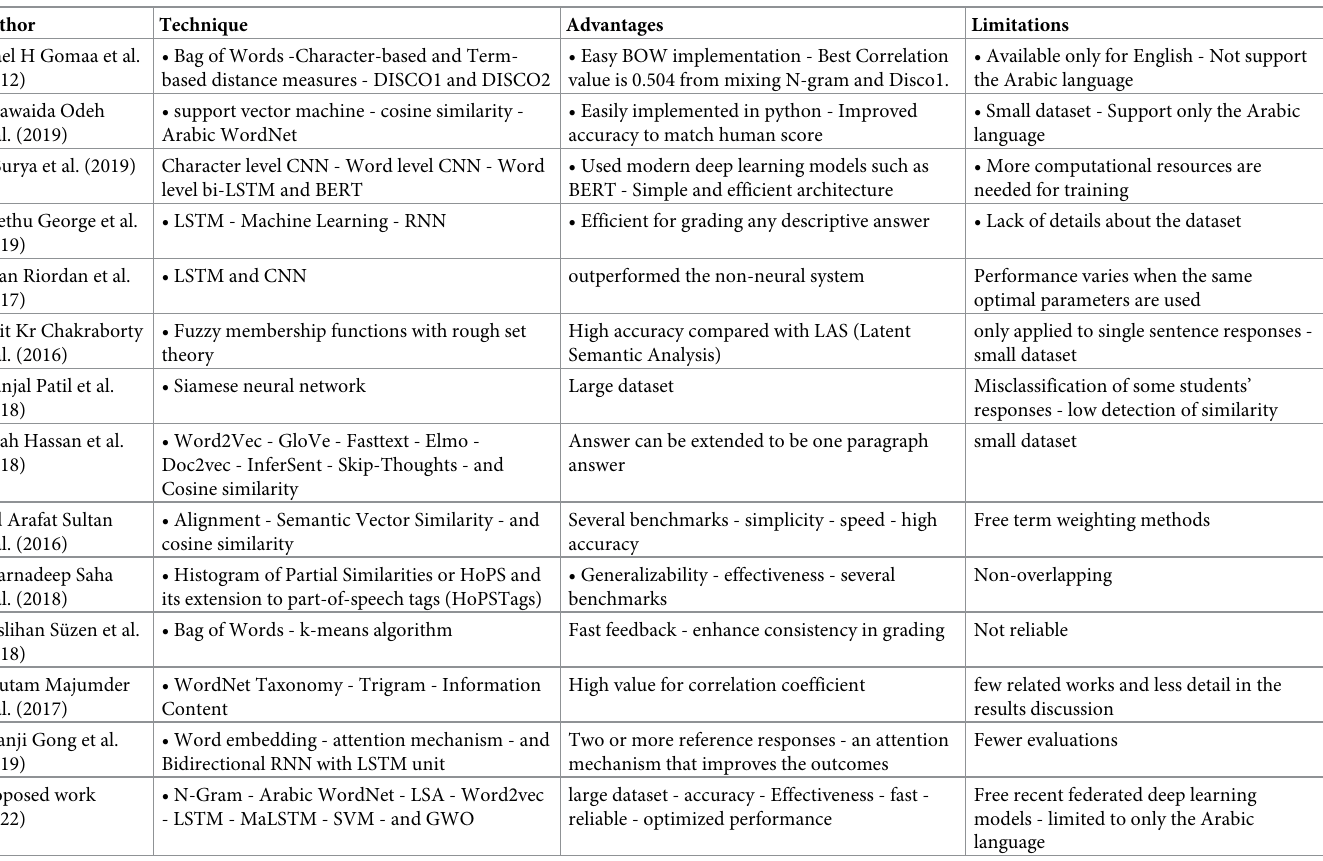
Table 1. A summary of related